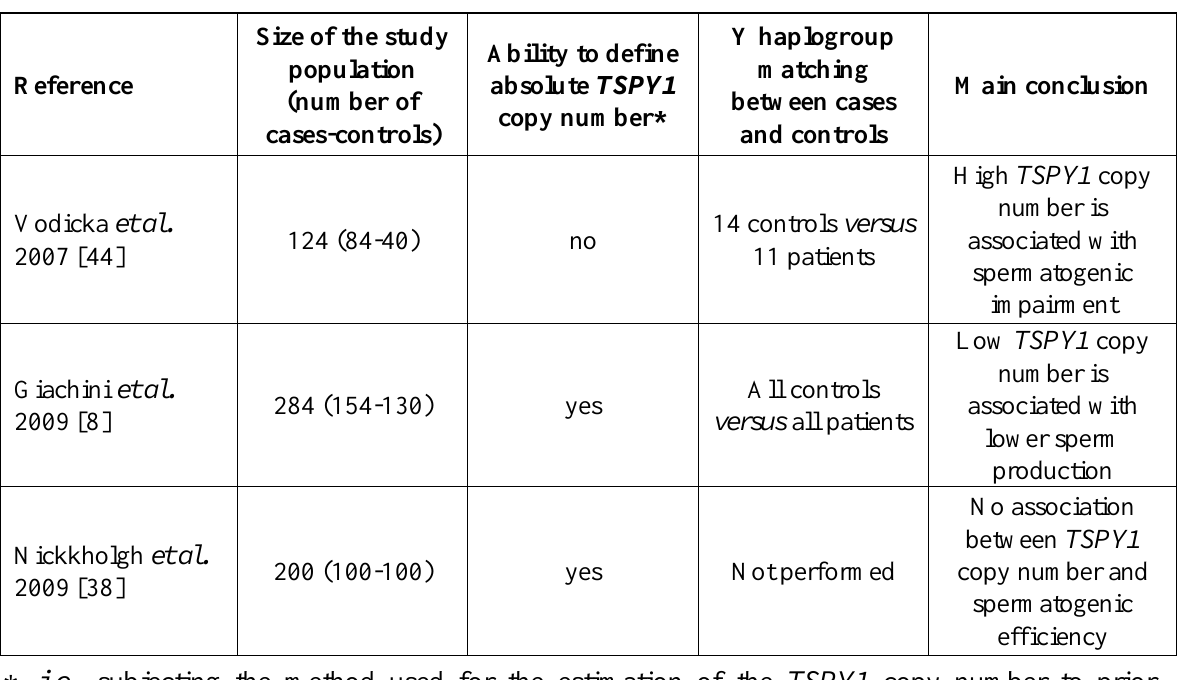
Table 1. Summary of case-control studies dealing with the role of TSPY1 copy number in male